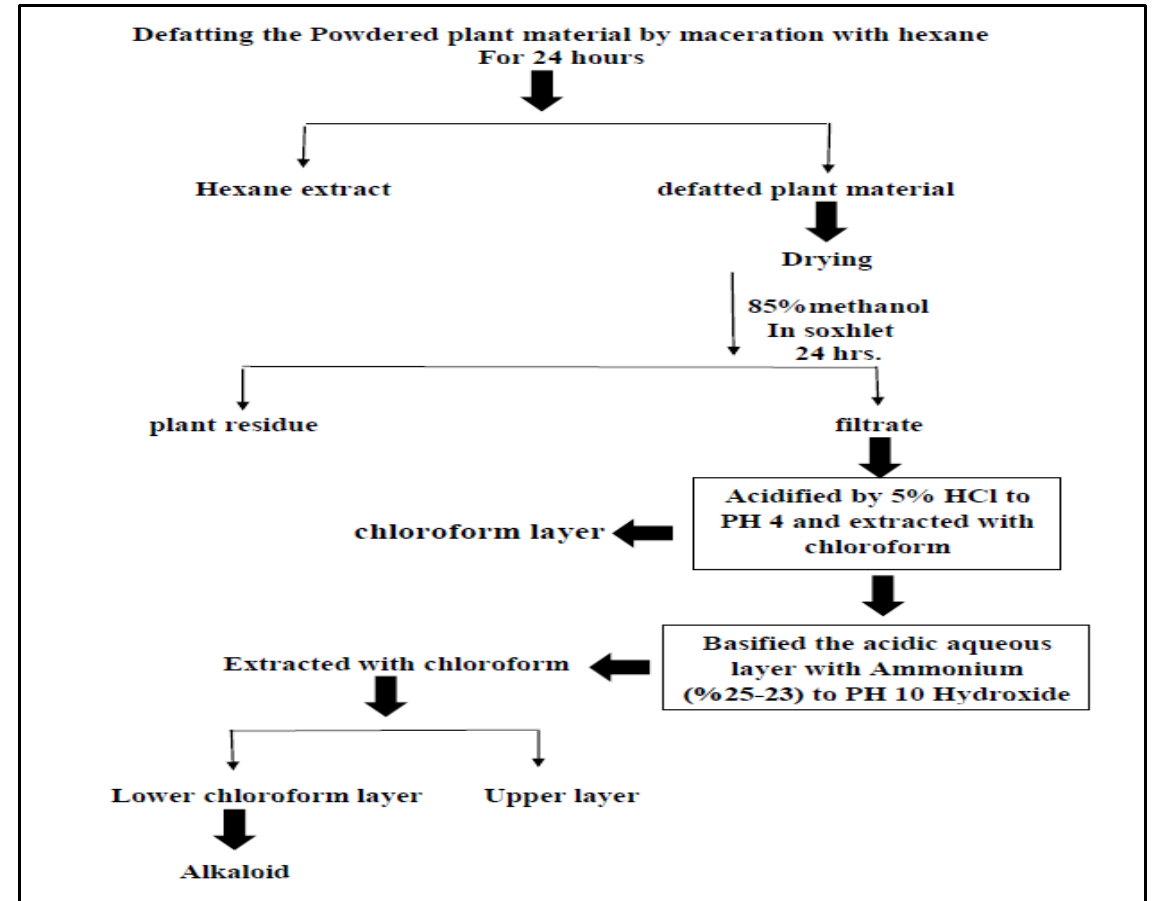
Figure 2. Steps of alkaloids